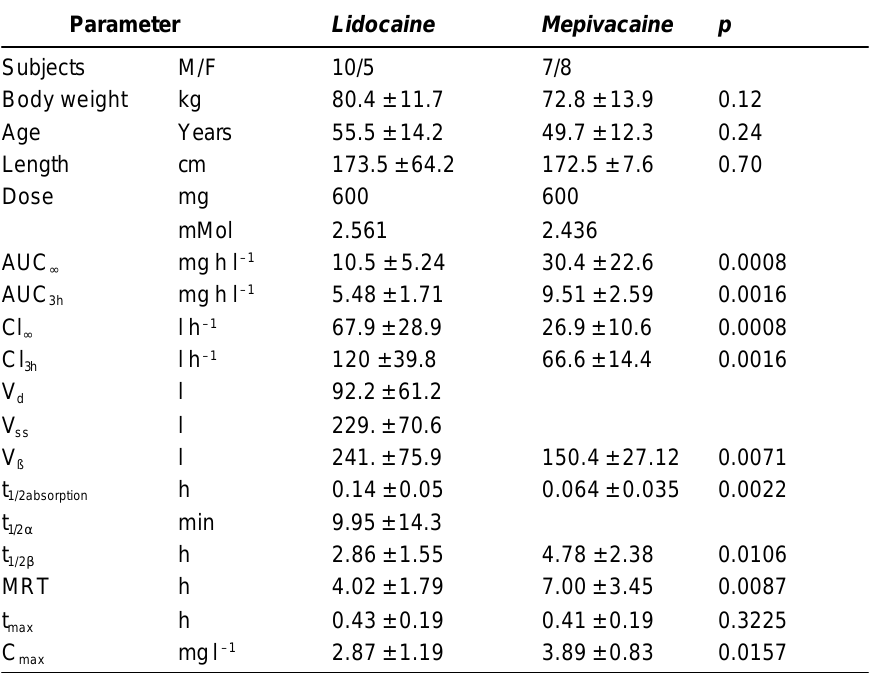
Comparison of the Pharmacokinetic Parameters (Mean ± s.d.) of Lidocaine and Mepivacaine after Axillary Administration